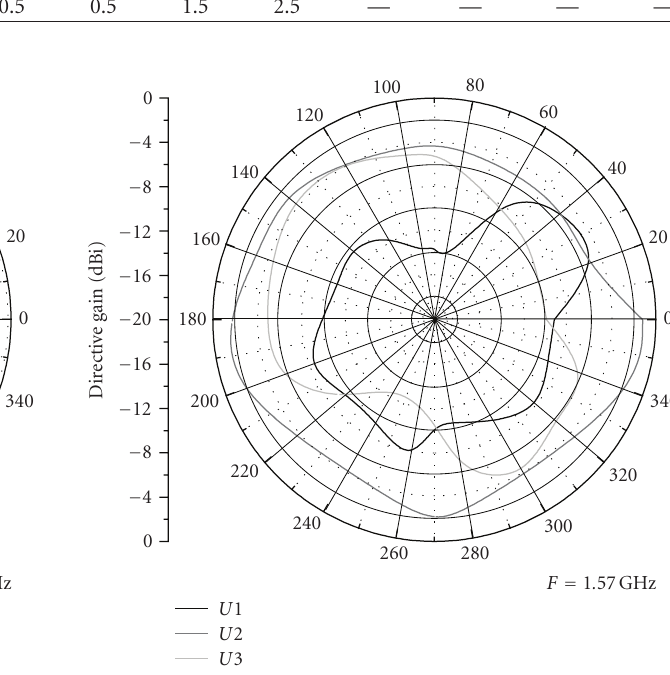
Figure 12: Directive gain for WiMAX at 3.47 GHz.